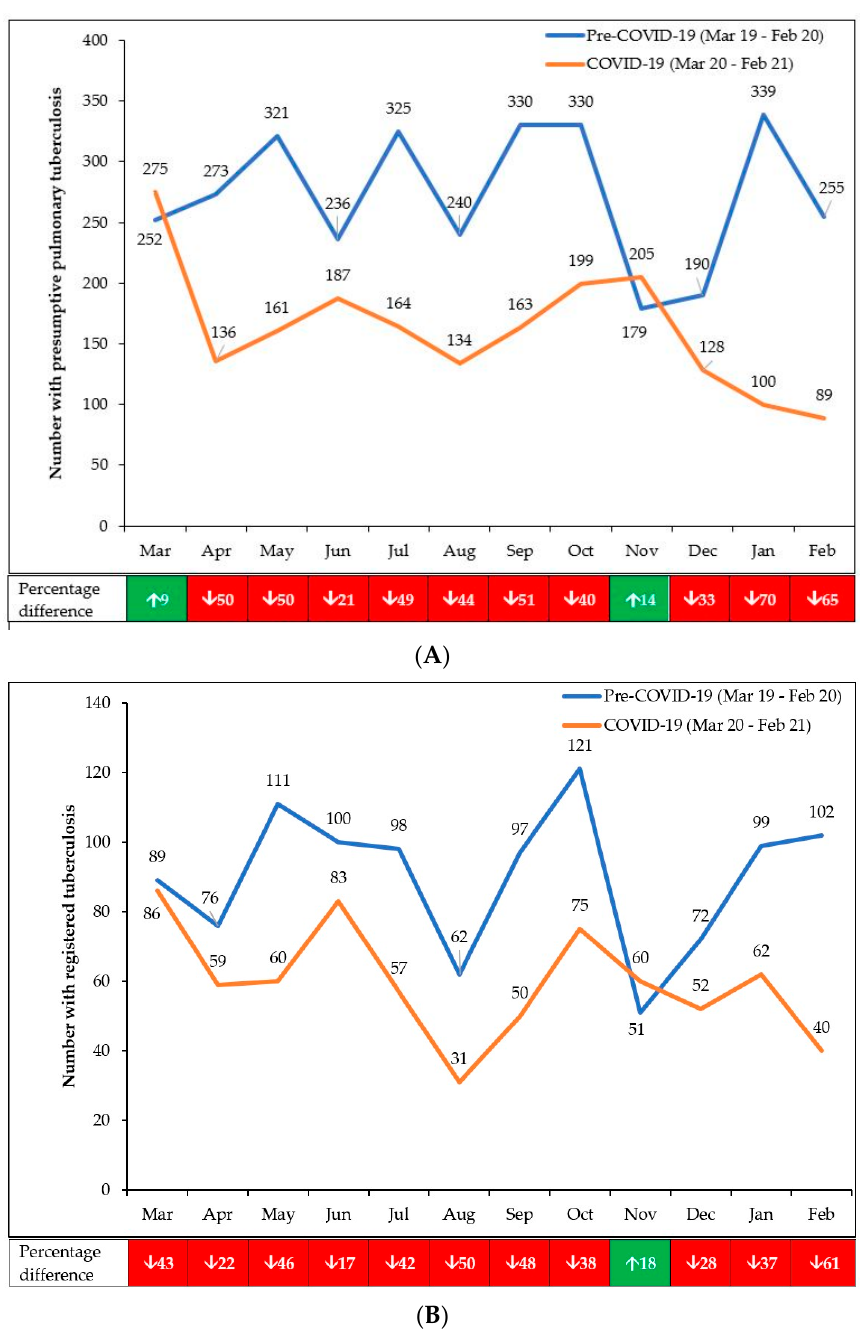
Figure 2. ( A ): Monthly numbers of persons presenting with presumptive PTB in 10 health facilities in Harare, Zimbabwe, during pre-COVID-19 and COVID-19 periods. ( B ): Monthly numbers of persons presenting with registered TB in 10 health facilities in Harare, Zimbabwe, during pre-COVID-19 and COVID-19 periods. ↑ = increase; ↓ = decrease. Interventions applied from July 2020 onwards to counteract the decline in numbers included: integrated screening of patients with respiratory symptoms for TB and COVID-19; improved contact tracing of index patients with TB and COVID-19; and strict infection control practices at health facilities which were promoted to try and encourage symptomatic patients to attend.